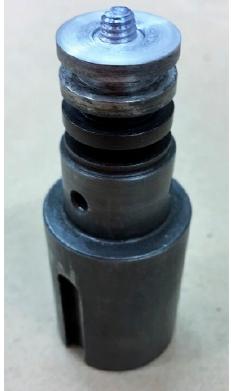
Figure 2. FSW tool used for the welding realization.